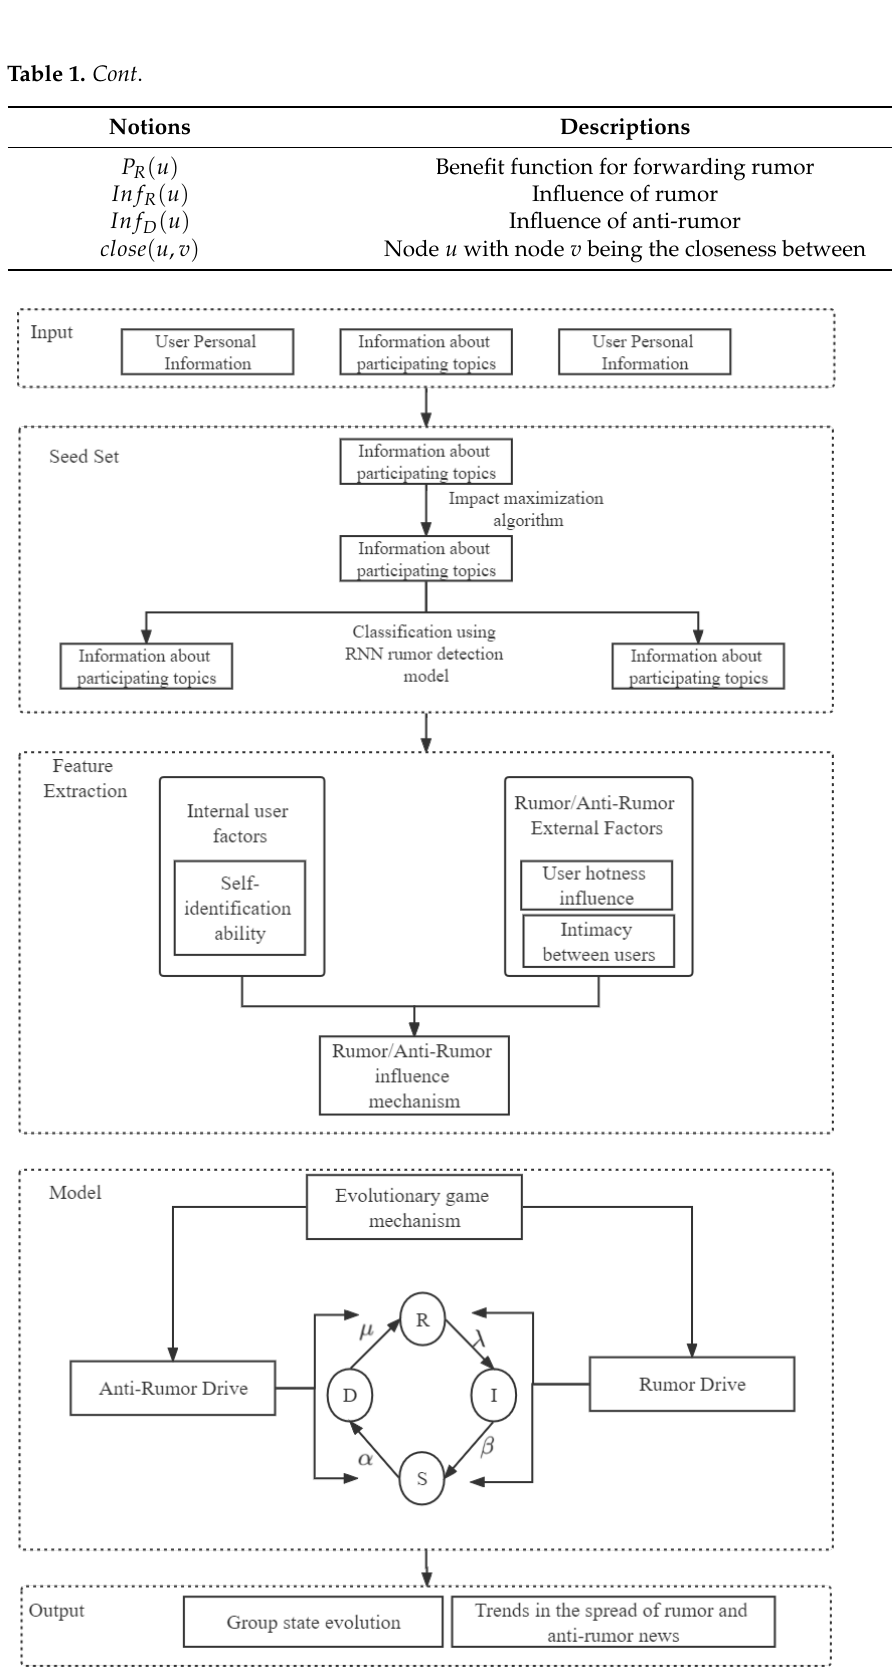
Figure 1. The framework of SDIR